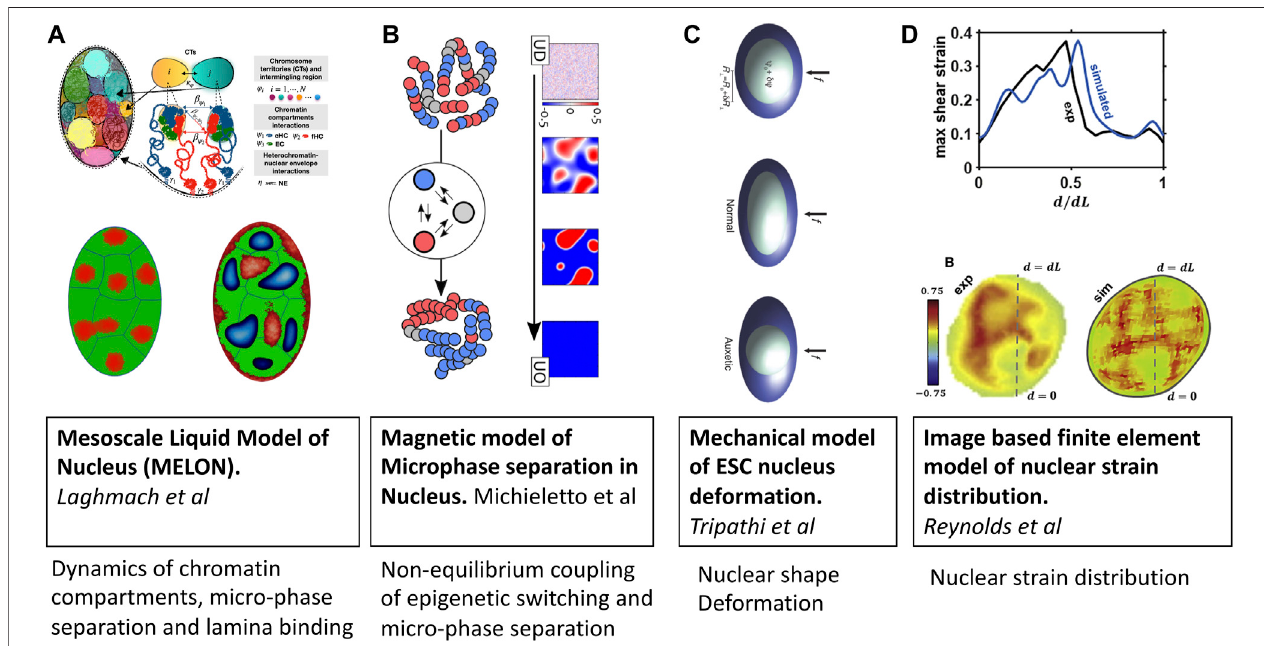
FIGURE 3 | Mesoscale models of eukaryotic nucleus. Images are adopted from original papers with copyright agreement. From left to right; (A) Mesoscale liquid modelofnucleusLaghmachetal.(2020),Laghmachetal.,2021, (B) MagneticmodelofchromatinphaseseparationbyMichieletto etal(2019), (C) Mechanicalmodelof stem cell nucleus deformation Tripathi and Menon (2019), and (D) Image based fi nite element model of nucleus Reynolds et al. (2021).